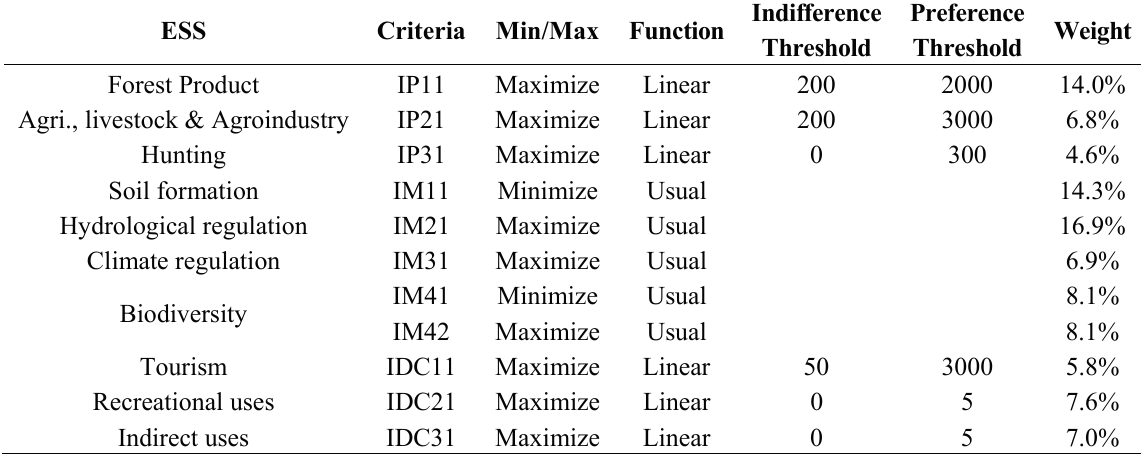
Table 4. Preferences functions and parameters for ESS